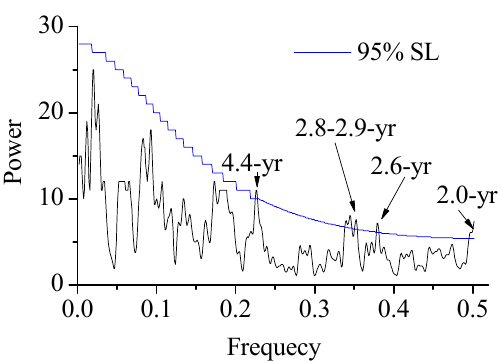
Figure 8. Multi-Taper Power spectra for the reconstructed SPEI (AD 1840–2014). 95% SL represents the 95% significance level.